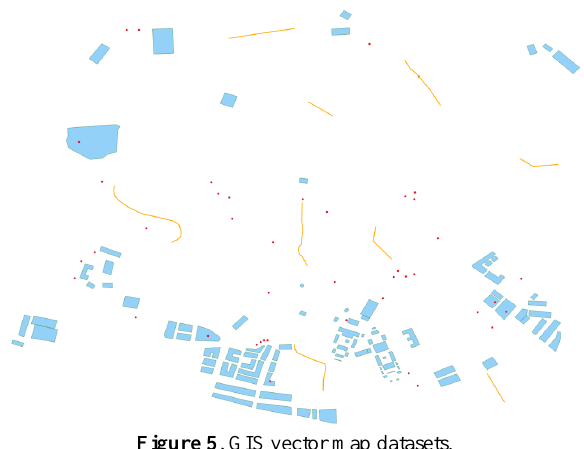
Figure 5 . GIS vector map datasets.